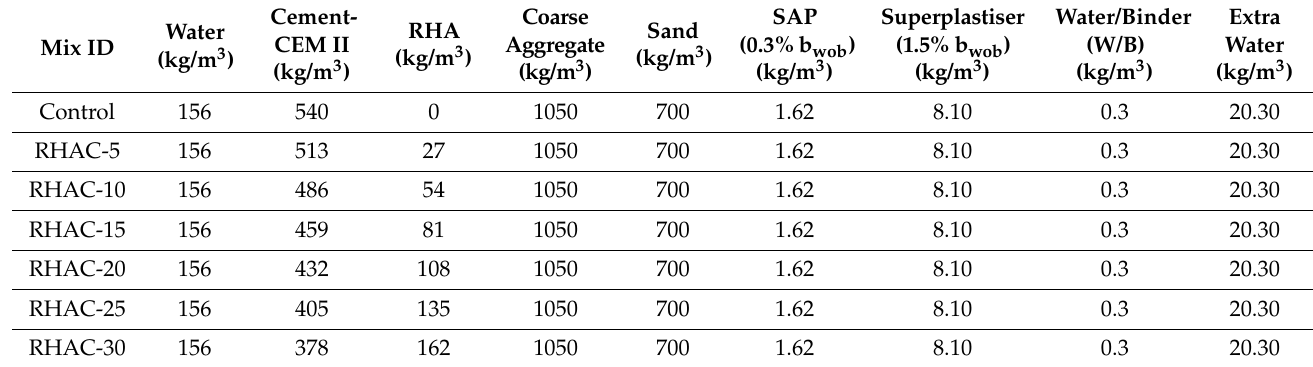
Table 1. Mix Constituents of HPC with